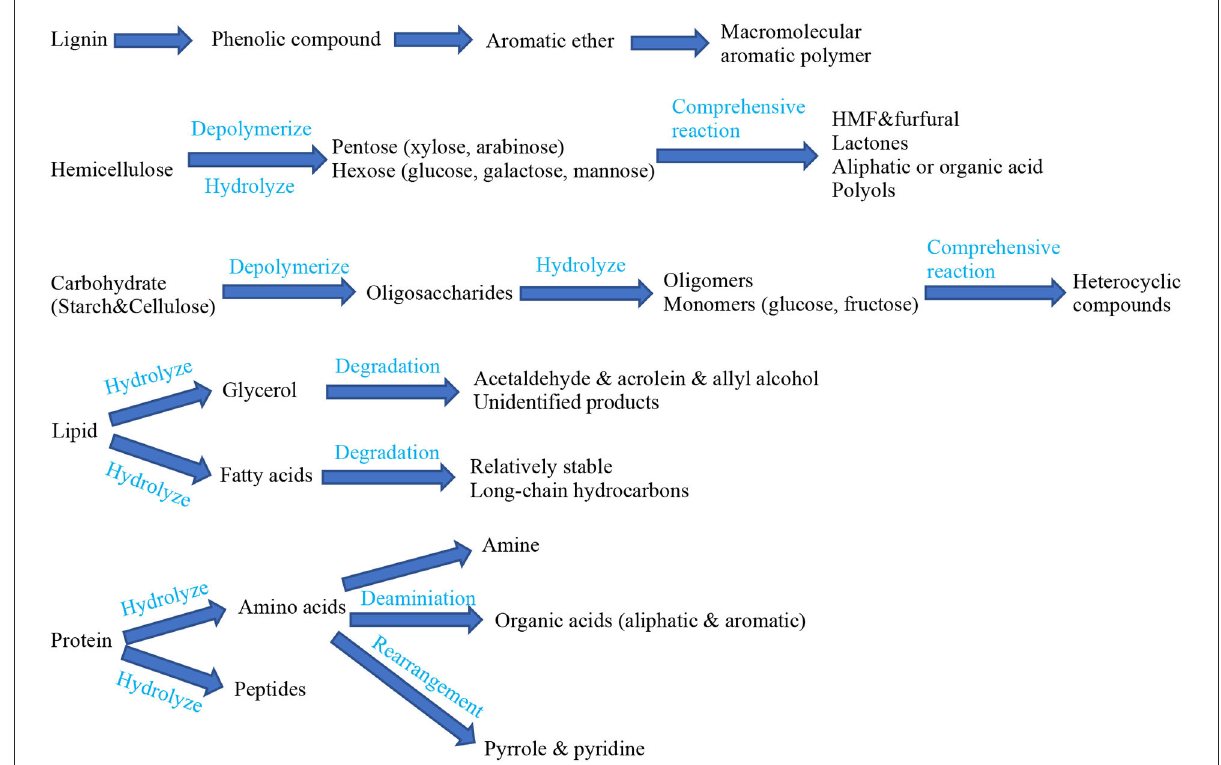
FIGURE1 Pathways for decomposition of main components of FW in HTC process (1,